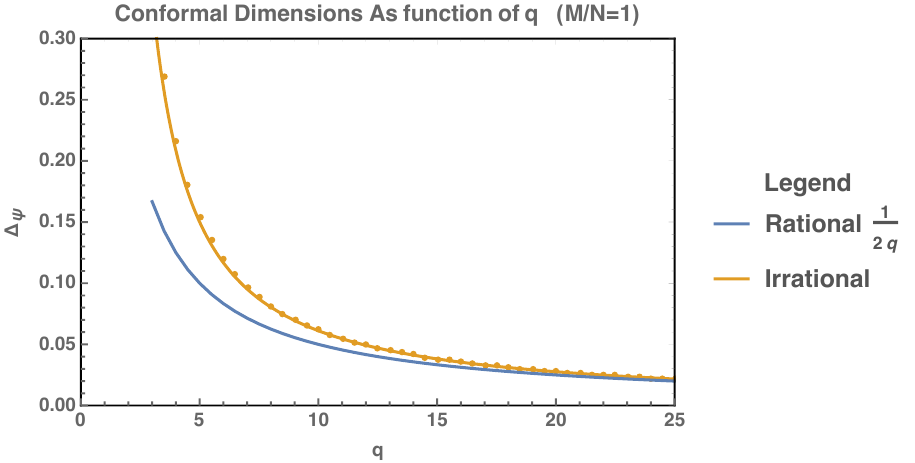
Figure 7. Here we plot the dependence of the conformal dimensions on the number of interactions q . Although we do not have the exact results for the irrational case, it is well approximated by the guessed solution in green. it can be seen that for large enough q the solutions approach one